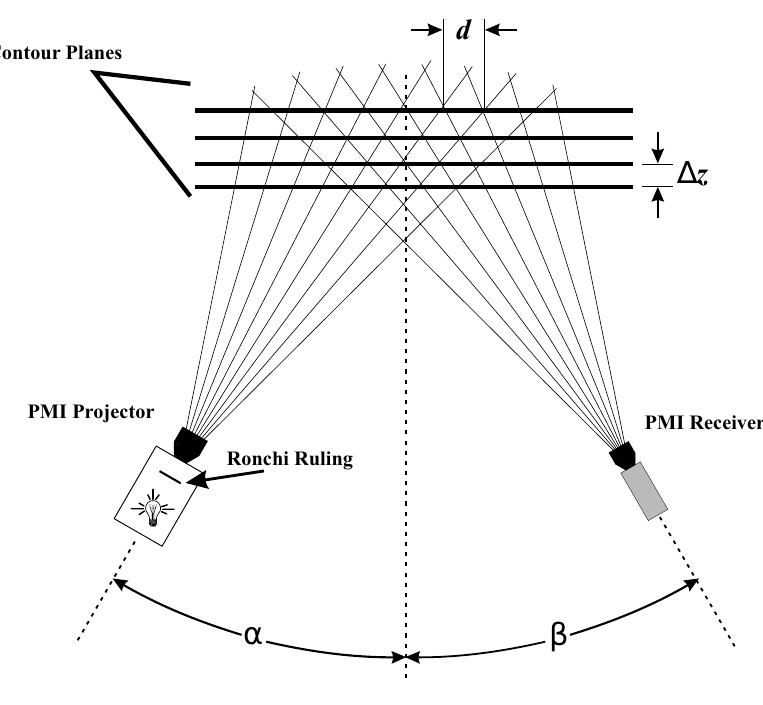
Fig. 2. Symmetric projection moir´e interferometry